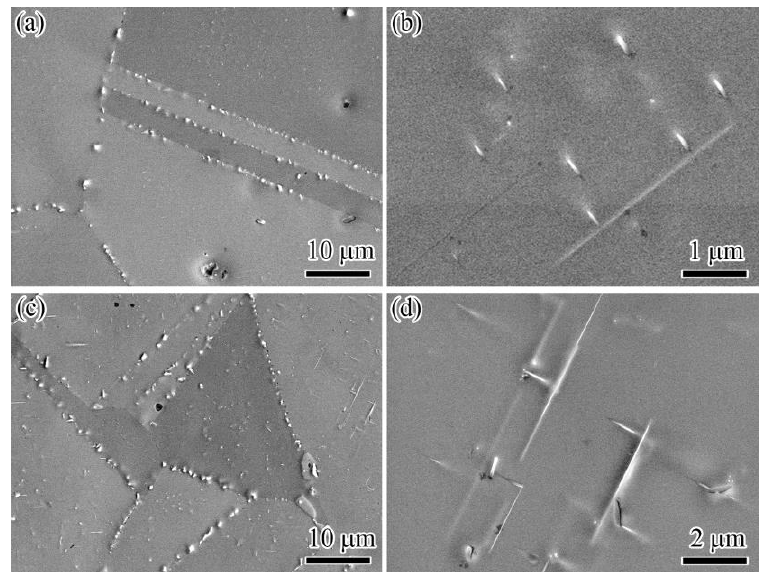
Figure 5. The SEM images of the 15Cr–15Ni–Ti–xP alloy after aging at 850 °C for 1000 h: ( a , b ) 15Cr– 15Ni–Ti–150P alloy and ( c , d ) 15Cr–15Ni–Ti–250P alloy.